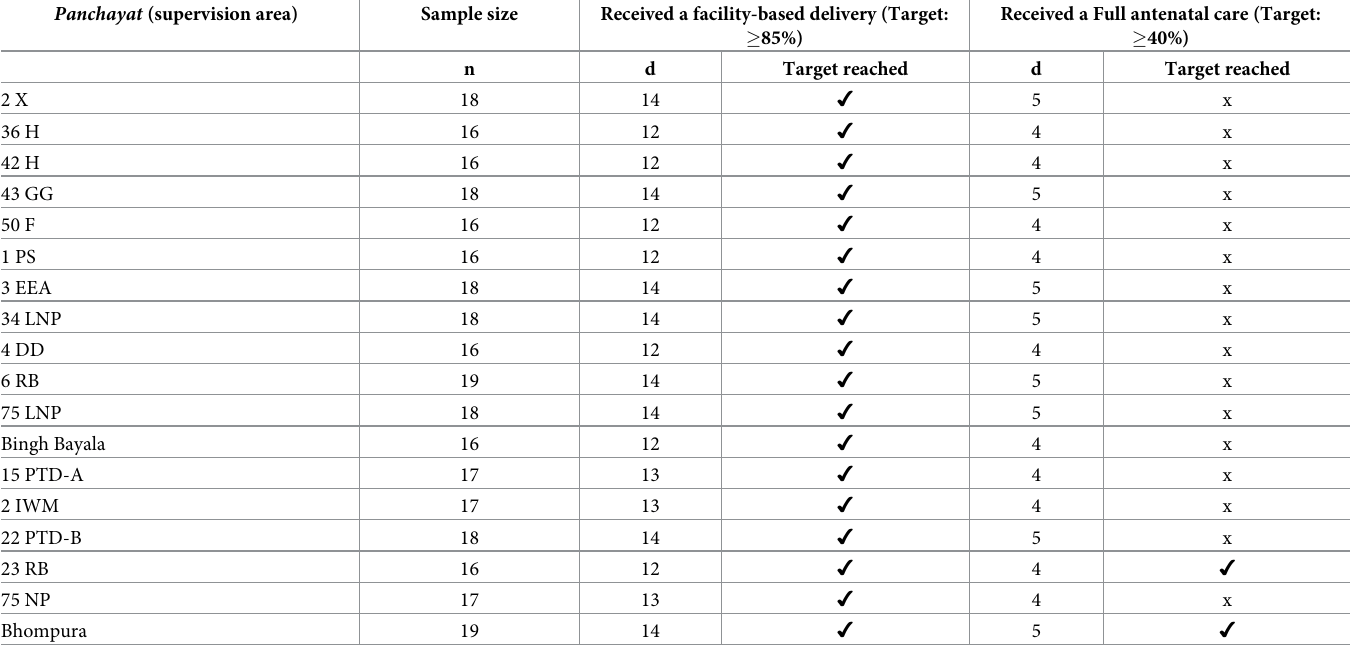
Table 1. LQAS results for indicator “facility-based delivery” and “full antenatal care” with sample sizes, decision rule, and whether target coverage was reached (yes — ✓ ; no—x) (n = 309). Panchayat (supervision